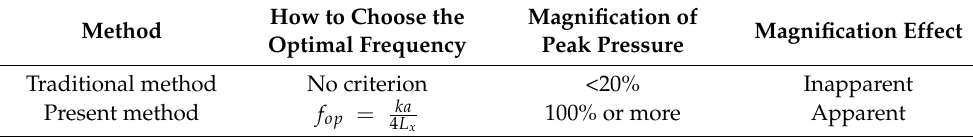
Table 2. Comparison between the present sine PHF method and traditional PHF